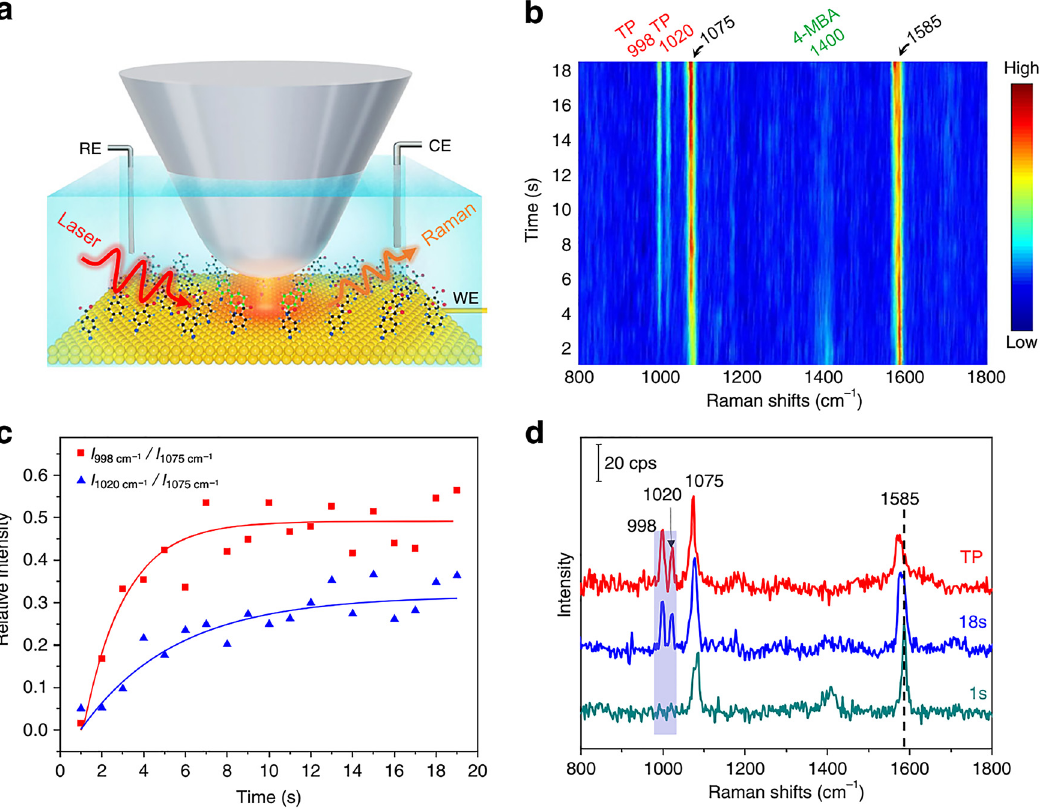
Figure 13: Decarboxylation of 4-mercaptobenzoic acid on Au (111). (a) Experimental set-up of EC-TERS where the reaction is driven under the coupled surface plasmon of silver tip and gold substrate. (b) In situ monitoring of thereactionby TERS(Power: 1.1mW,bias:200 mV,Itunneling: 800pA). (c)Relativeintensity of vibrationbands(998 and1020 – 1075 cm − 1 ) against time. (d) Representative TER spectra of 4-mercaptobenzoic acid and thiolphenol (TP)